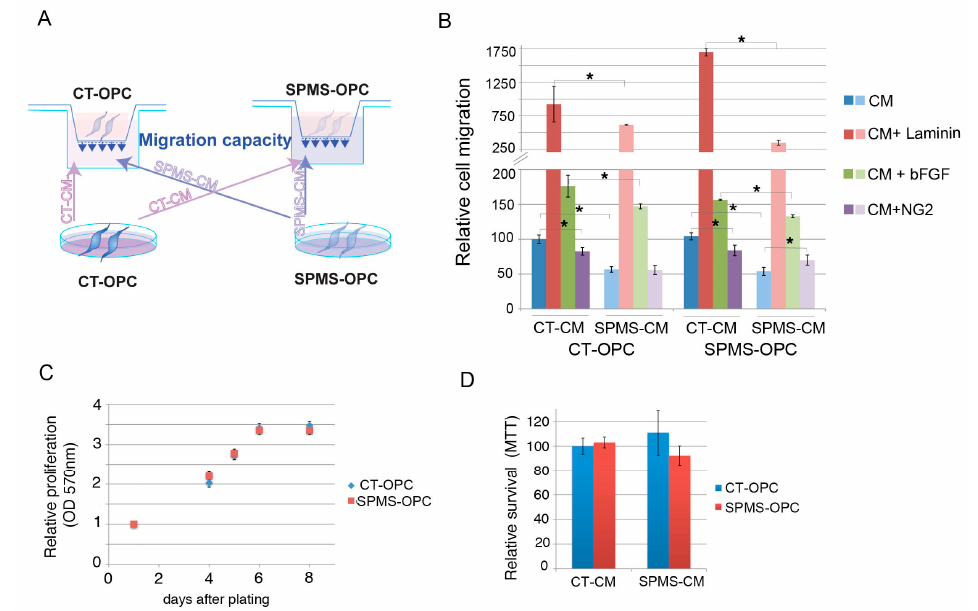
Figure 5. Progressive SPMS-OPC secretome shows deficient in vitro OPC migration stimulation. ( A ) Schematic protocol of migration assay. SPMS- and CT-derived early OPC-like cells were culture in fasting media, and conditional media (CM) were recovered after 24 h and added to the lower well of transwell chambers. SPMS- and CT-derived early OPC-like cells were plated on upper wells of transwell chambers, and 24 h later, migrated cells on the lower membrane surface were fixed, crystal violet stained, and quantified by optical density (OD 540) values of stained cell extracts. ( B ) Quantification of cell migration (OD 540) under CT- or SPMS-derived CM with indicated stimulating factors (laminin, bFGF, or NG2) relative to the CT-OPC-like sample under CT CM stimulation. Error bars represent means ± SEM ( n = 6 independent experiments with early OPC-like cell lines from four different SPMS and three CT donors) * p ≤ 0.05 by unpaired Student’s t -test. ( C ) SPMS- and CT-derived early OPC-like cells present similar proliferation rates. A total of 25,000 OPC-like cells were cultured with NIM/bFGF/purmorphamine for proliferation/viability MTT (3-(4,5-dimethylthiazol-2-yl)-2,5-diphenyltetrazolium bromide) assay. Cells were recovered 1, 4, 5, 6, and 8 days after and measured at 570 nm absorbance, reflecting the number of viable cells (MTT assay). Average relative absorbance ± SEM (relative to day 1) is represented ( n = 3 independent experiments with early OPC-like cell lines from four different SPMS and three CT donors). ( D ) CT and SPMS-derived OPC-like cells were cultured for 24 h in CM as in Figure 5A, and after 48 h, the number of viable cells (MTT assay) was measured. Average relative absorbance ± SEM is represented ( n = 3 independent experiments with OPC-like cell lines from four different SPMS and three CT donors).